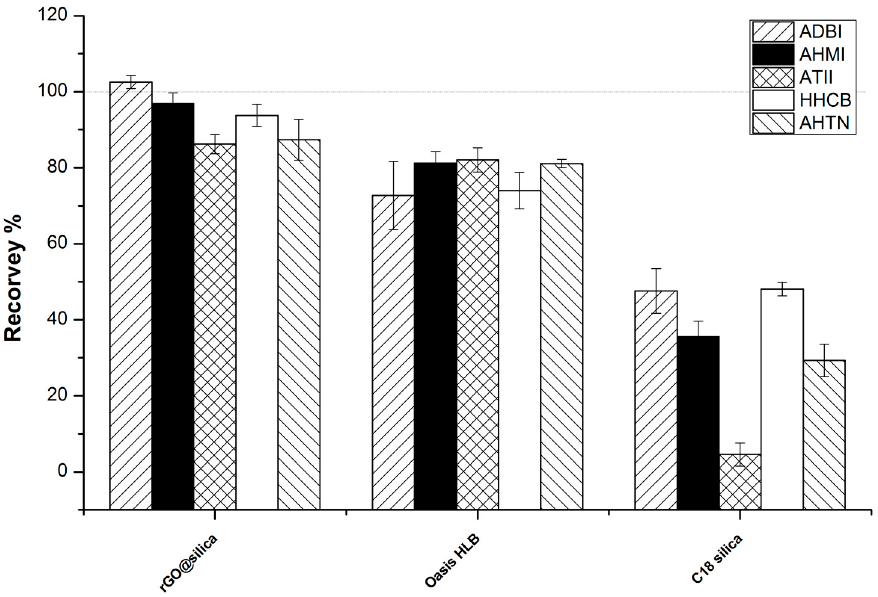
Figure 5. Comparison of the performance of rGO@silica with that of several other sorbents.